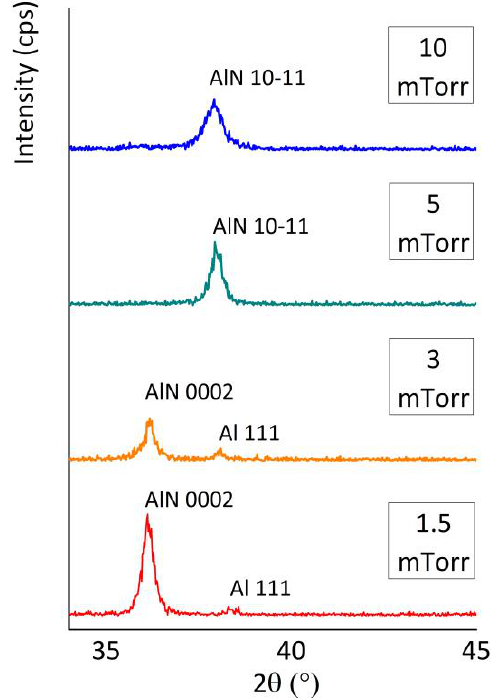
Figure 6. X-ray diffraction (XRD) θ–2θ scans of AlN thin films at different working gas pressures.